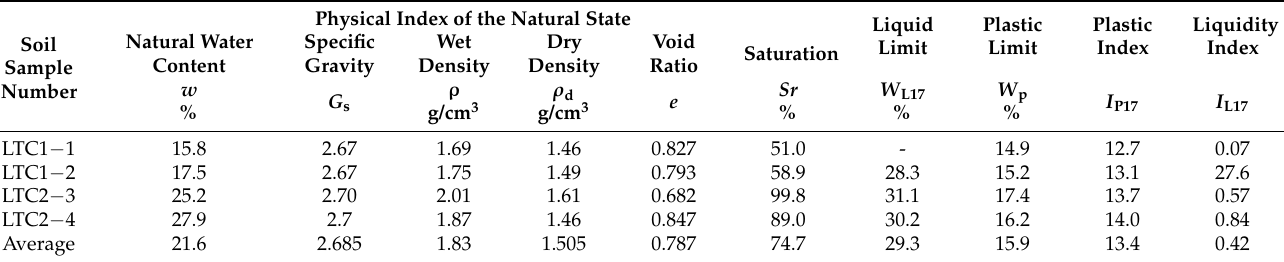
Table 1. Luohuang Town Soil Physical Test